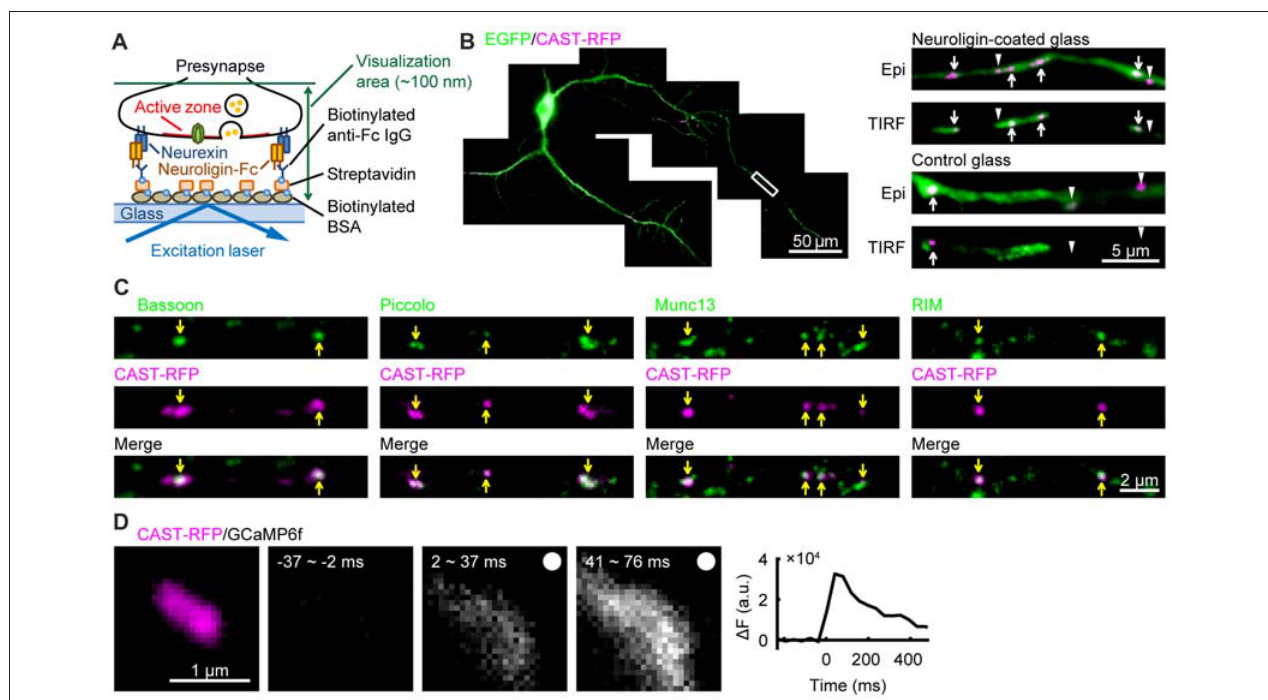
FIGURE 1 | Formation of active-zone-like membranes (AZLMs) on neuroligin-coated glass. (A) Schematic presentation of AZLM formation on a cover glass coated with neuroligin. (B) AZLMs and normal active zones observed with an epi-fluorescence (Epi) or total internal reflection fluorescence (TIRF) condition. White rectangular area in the left image was magnified in the right top. Green and magenta show EGFP and cytomatrix at the active zone-associated structural protein (CAST)-RFP signals, respectively. (C) Co-localization of CAST-RFP (magenta) with Bassoon, Piccolo, Munc13 or RIM (green). (D) GCaMP6f signal increase around an AZLM marked with CAST-RFP (left magenta). The right graph shows the time course of change of GCaMP signal intensity. Electrical stimulation (100 Hz, 5 pulses) was applied at 0